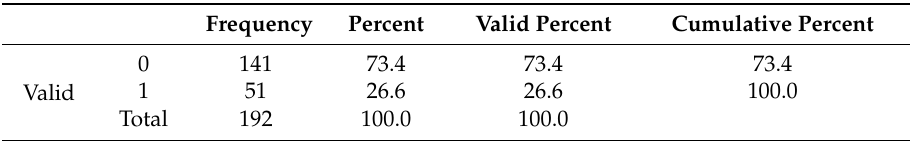
Table 19. Frequency table: rental for